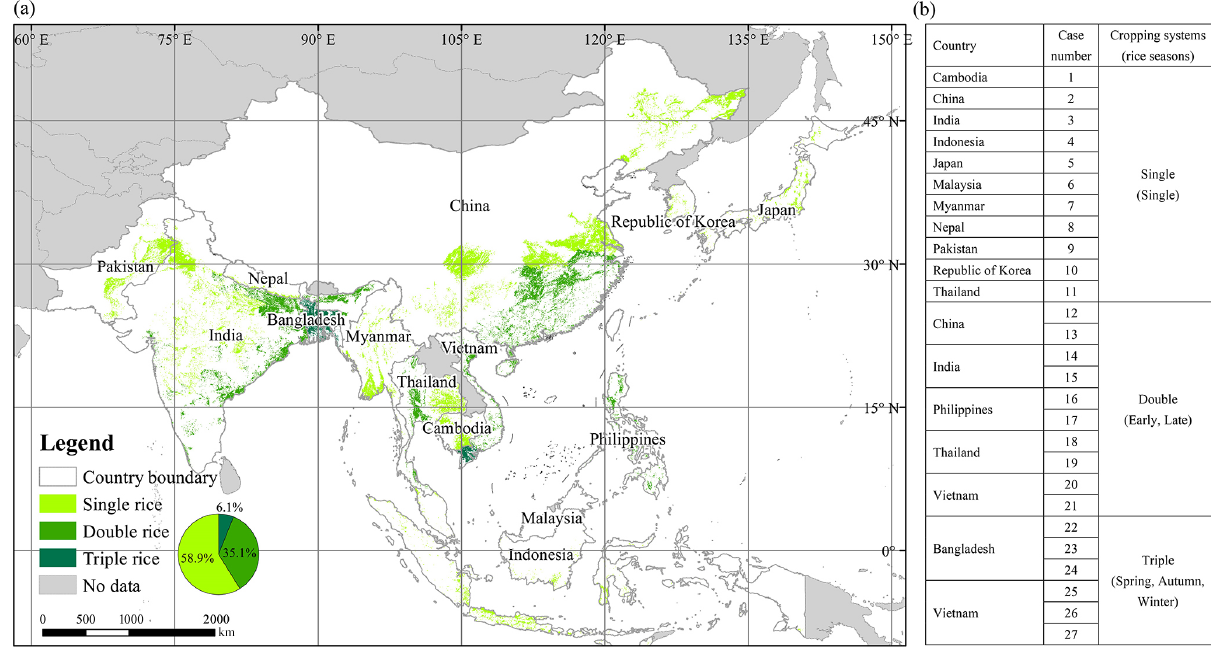
Figure 1. (a) Rice cultivation areas with different cropping systems in the main rice-producing countries of Asia. The green area represents the maximum rice paddy area where paddy rice grew for at least 1 year during the 1995–2015 period (Han et al., 2021, 2022). The pie chart represents the area proportion of different rice-cropping systems. Panel (b) presents the case numbers and cropping system for each country. Double rice follows the order of early before late (e.g., 12 and 13 represent the early-season rice and late-season rice in China, respectively), and triple rice follows the order of spring, autumn and winter (e.g., 25, 26 and 27 represent the spring season rice, autumn season rice and winter season rice in Vietnam,